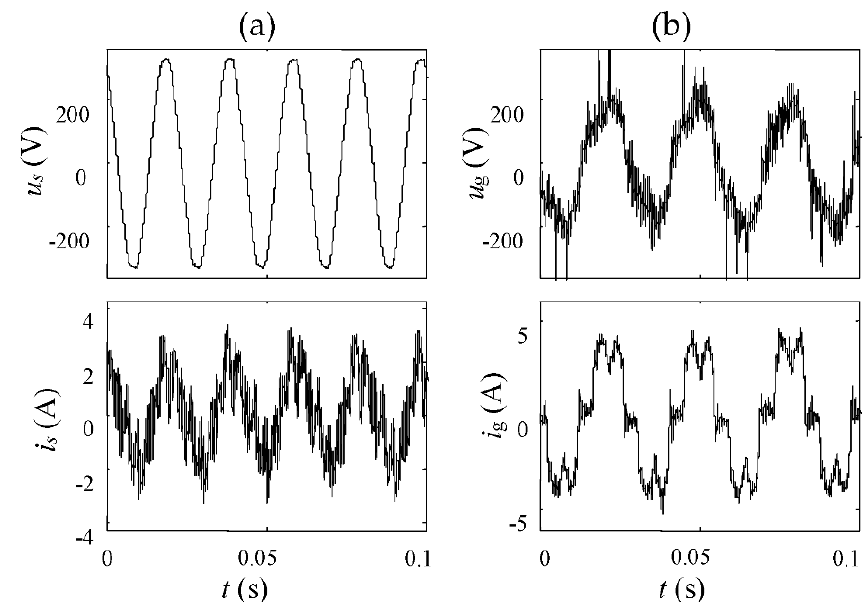
Figure 12. Electrical signal (voltage and current) analysis of the PEU with diode bridge rectifier: ( a ) PEU output signal; and ( b ) PMSG signal .